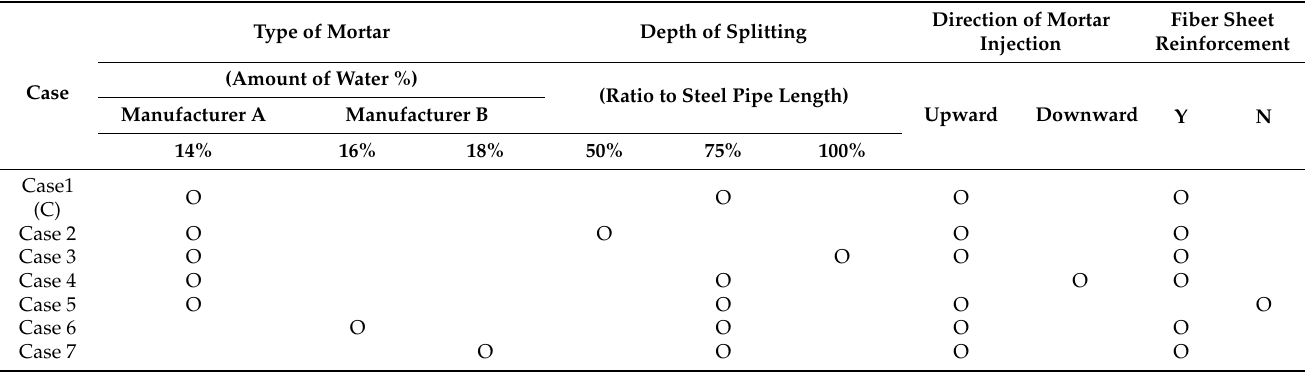
Table 2. Setting parameters for cable bond performance